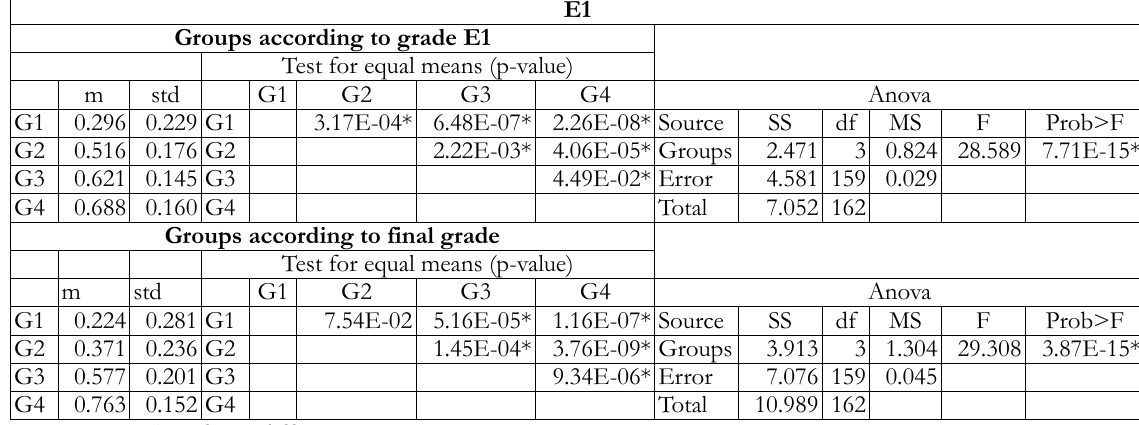
Table 4. Descriptive features of variable